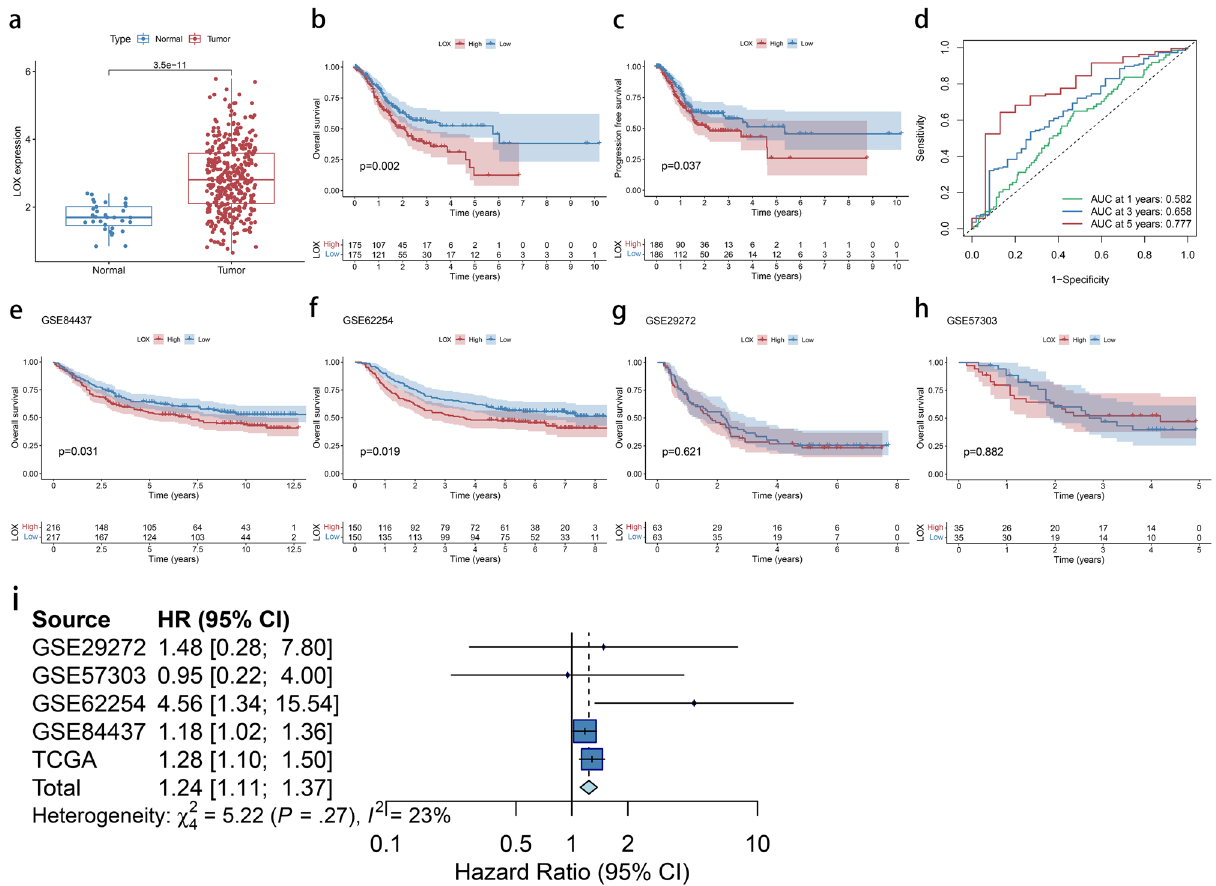
Figure 6. Prognosis and expression analysis of LOX in the TCGA and GEO databases. ( a ): The LOX gene was expressed at a significantly higher level in GC tissues than in normal ( P < 0.001). ( b ): Patients with high LOX levels had poor OS than those patients with low ( P = 0.002). ( c ): Patients with high LOX levels had poor PFS than those patients with low ( P = 0.037). ( d ): Survival-reliant ROC curves confirm the prognosis value of LOX- based prognosis indexes. ( e ): K-M curves of the OS of 433 GC sufferers from GSE84437 ( P = 0.031). ( f ): K-M curves of the OS of 300 GC sufferers from GSE62254 ( P = 0.019). ( g ): K-M curves of the OS of 126 GC sufferers from GSE29272 ( P = 0.621). ( h ): K-M curves of the OS of 70 GC sufferers from GSE57303 ( P = 0.882). ( i ): Forest plot of high LOX expression versus low LOX expression (HR = 1.362, 95% CI = 1.11–1.37). Hazard ratios were analyzed with the fixed-effect